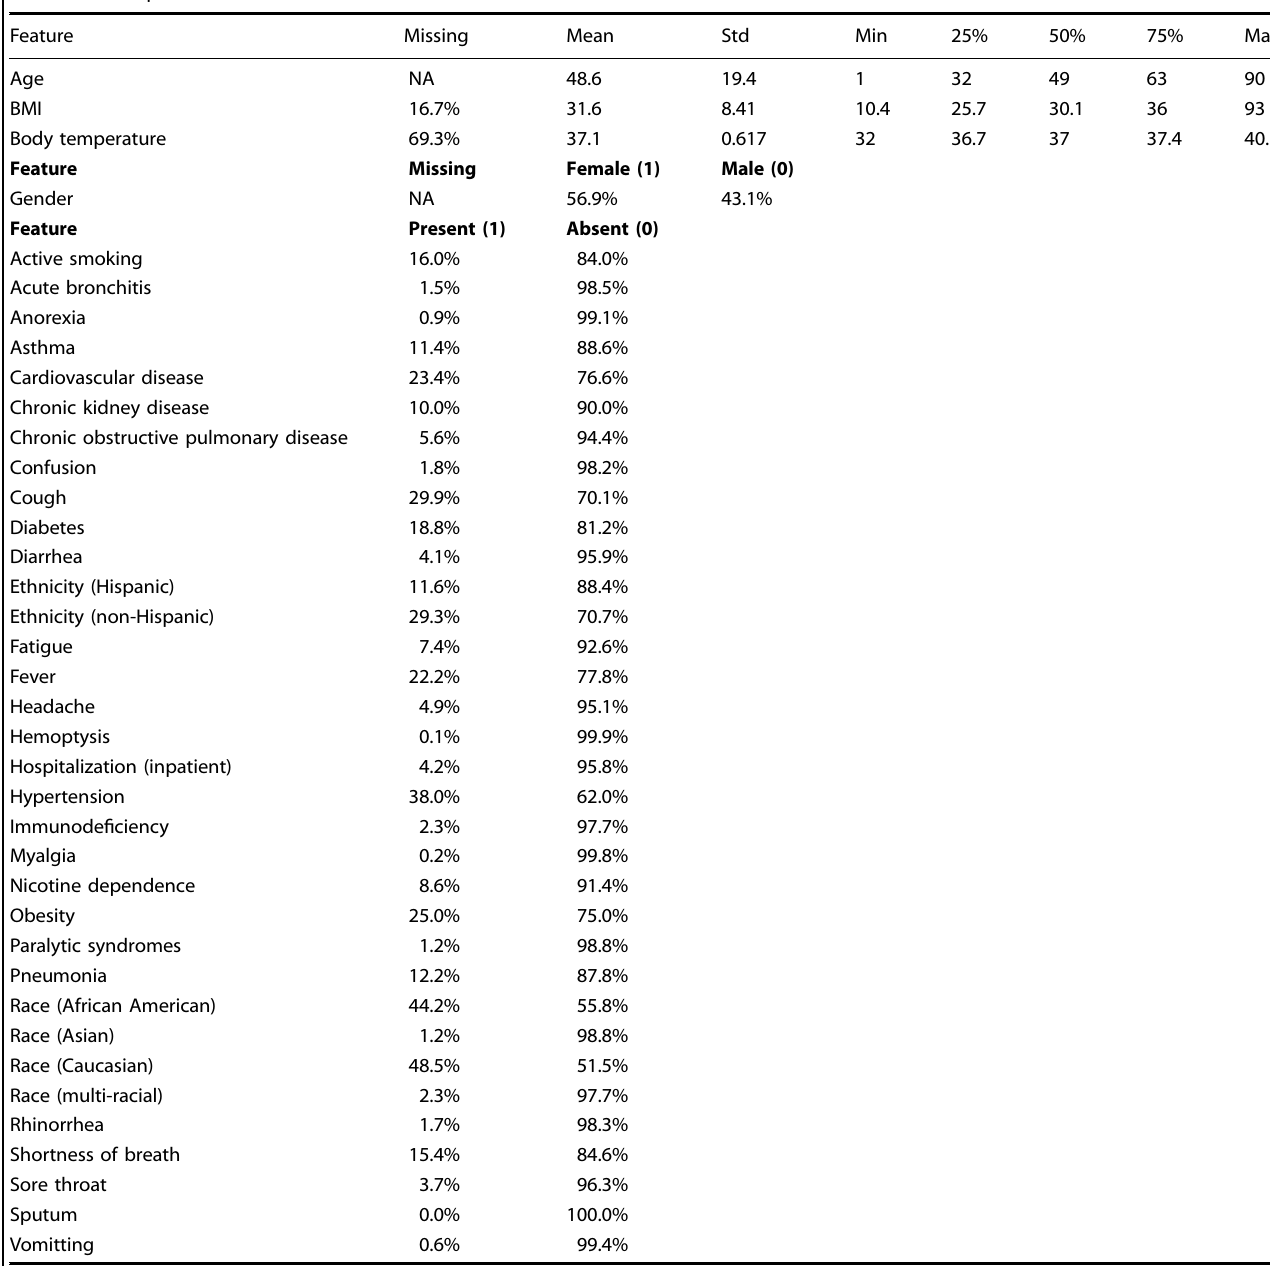
Table 2. Descriptive statistics of the